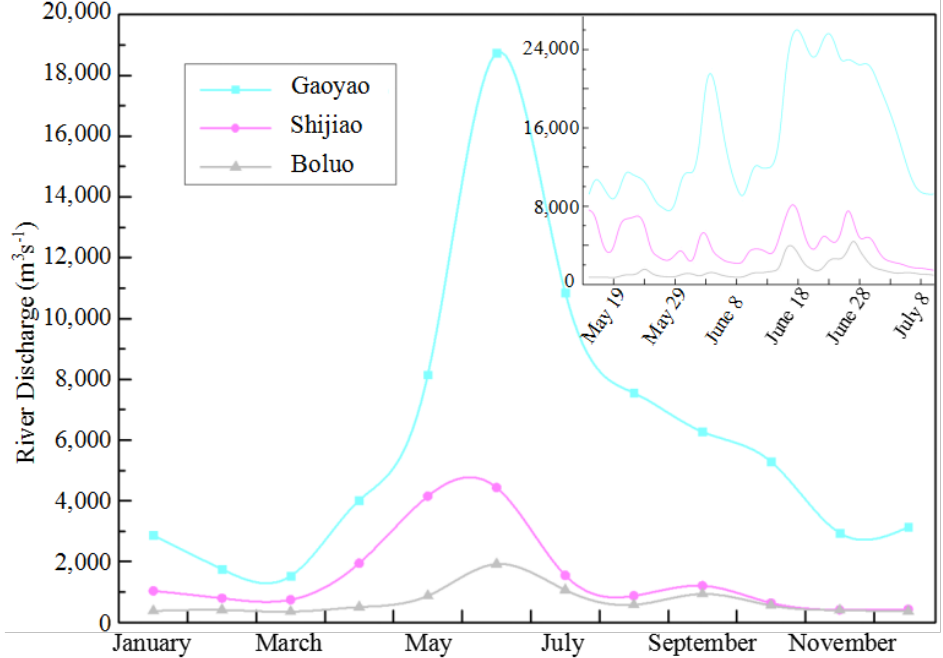
Figure 3. Monthly mean freshwater discharges at Shijiao, Gaoyao, and Boluo Stations in 2010. The insert shows the daily discharge data during the study period.